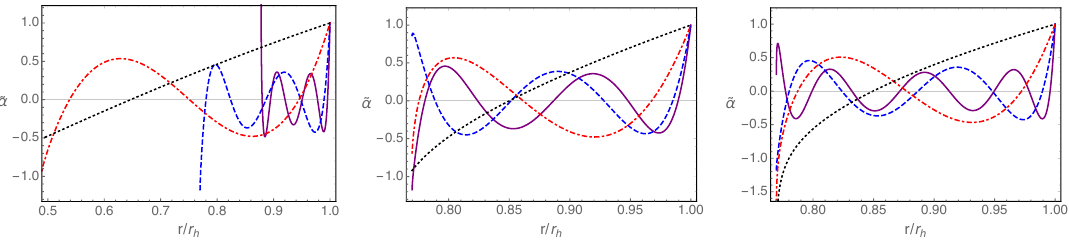
Figure 6 . The plots of ˜ α = α/α h along radial direction in the oscillation region for fixing α b = 0 . 01 , k/µ = 5 ( left ) while T/µ = 0 . 05 (purple), 0 . 1 (blue), 0 . 3 (red), 1 (black), for fixing T/µ = 0 . 1 , k/µ = 5 ( middle ) while α b = 0 . 01 (purple), 0 . 5 (blue), 1 (red), 2 (black), and for fixing α b = 0 . 01 , T/µ = 0 . 1 ( right ) while k/µ = 8 (purple), 5 (blue), 3 (red), 1 (black). Note that α h is the horizon value of α